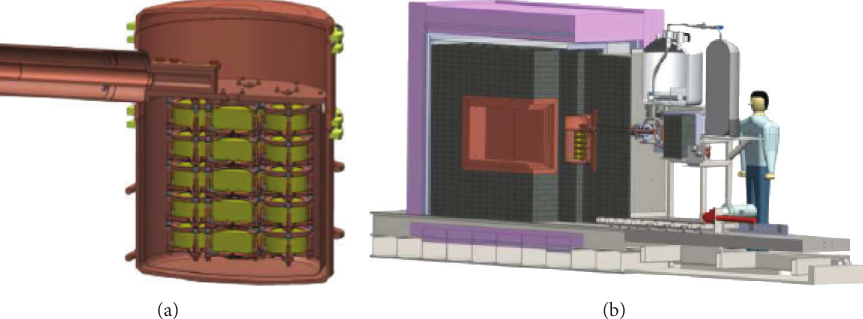
Figure 13: The MAJORANA Demonstrator: (a) cross-sectional view of one cryostat and (b) of the entire apparatus showing one cryostat while being inserted in the shield (figure from